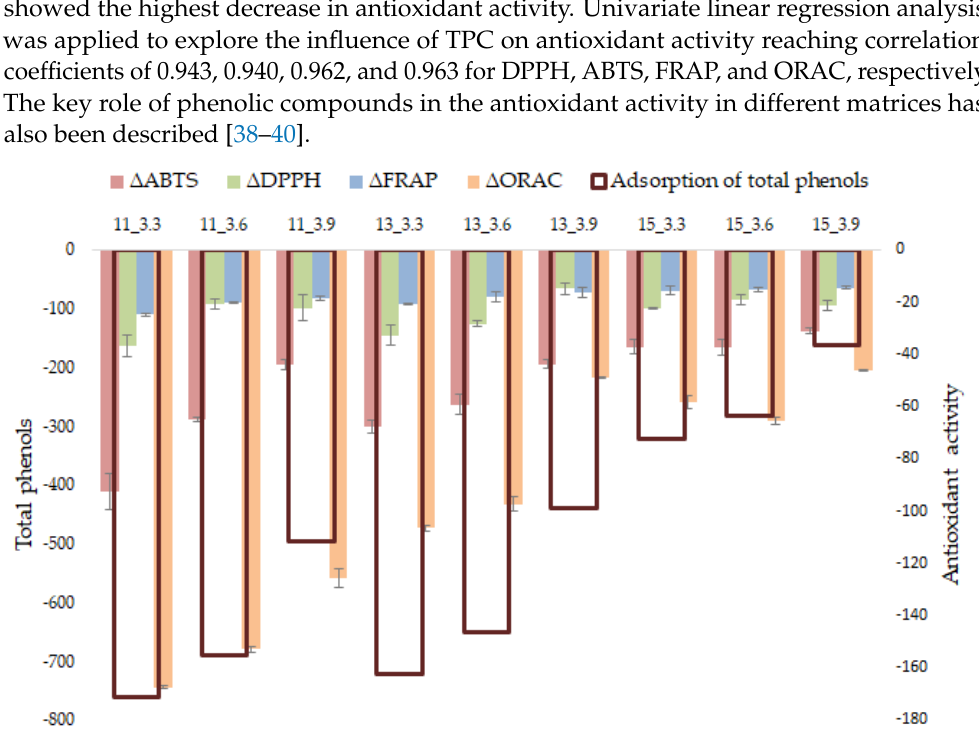
Figure 2. Influence of wine pH and ethanol content on adsorption of total phenolics (mg Eq gallic acid/L) and antioxidant activity modification (mg EqTE/L for ABTS, DPPH and ORAC, mg Eq AAE/L for FRAP) of wines fining with GSP.